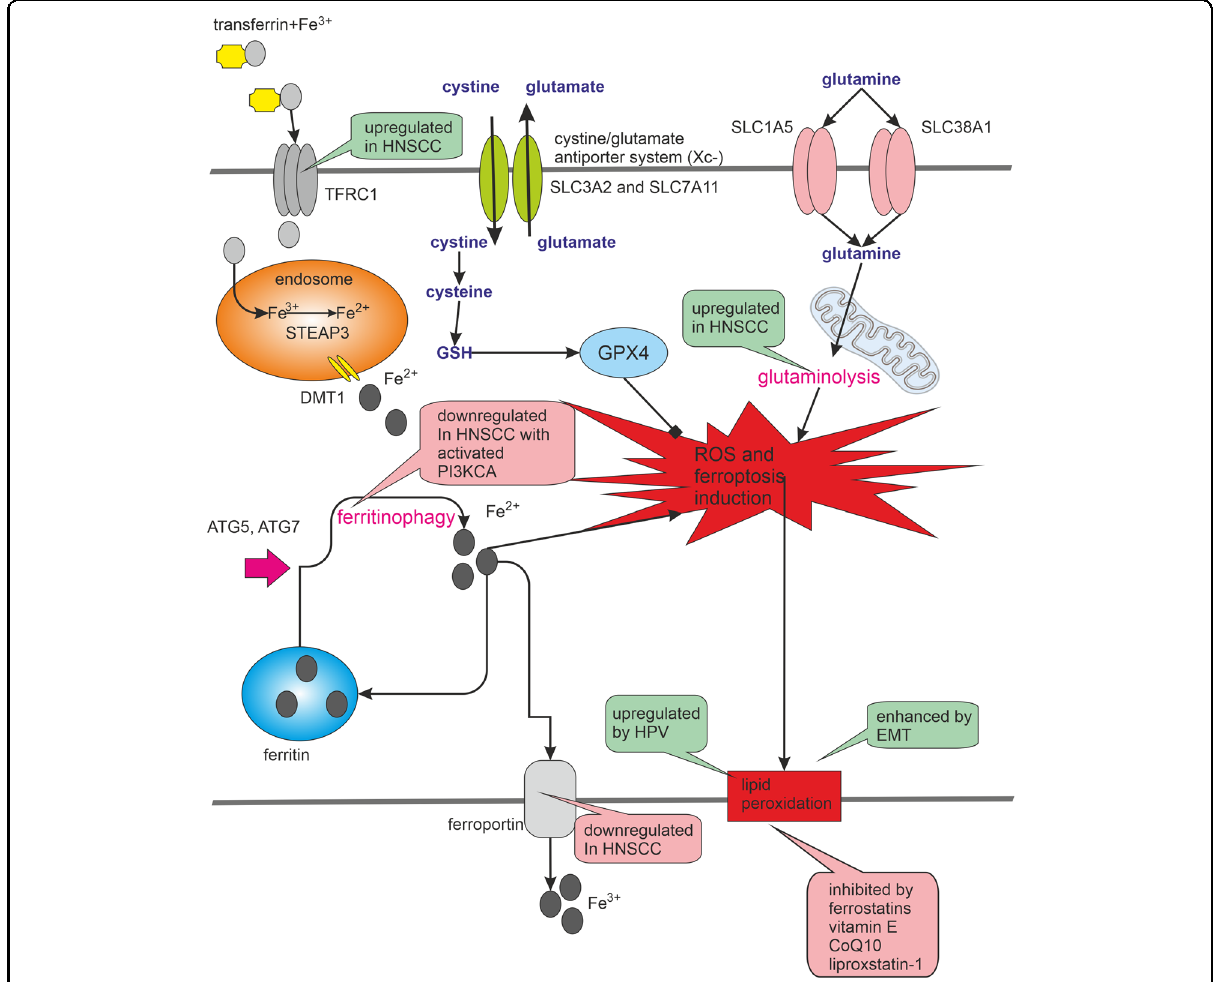
Fig. 3 Ferroptosis. Ferroptosis is characterised by iron-induced lipid peroxidation. The intracellular concentration of iron can be affected by the activity of transferrin, transferrin receptor and ferroportin, or by the release of iron from ferritin, which is often managed by ferritinophagy. HNSCC cells often manifest an increased intracellular iron concentration due to a high level of TFRC1 (transferrin receptor 1 responsible for cellular iron uptake) and a low abundance of ferroportin (responsible for iron ef fl ux). The non-physiological degree of lipid peroxidation and the initiation of ferroptosis is prevented by glutathione and glutathione peroxidase 4 (GPX4) activity. Ferroptosis could be also prevented with chelating agents or vitamin E, which casts a bad light on the bene fi ts of antioxidants in the treatment of some ferroptosis-prone cancers. Glutamine and glutaminolysis also play a crucial role in the activation of ferroptosis. PI3KCA is among the most frequently mutated and activated genes in HNSCC. PIK3CA activation can lead to increased mTOR activity and decreased autophagy. Consequently, the presence of PI3KCA activation may predispose these cancer cells to avoid autophagy, ferritinophagy and ferroptosis. The ferroptotic signalling pathways are signi fi cantly in fl uenced by HPV infection and by the genetic background of HNSCC. Green bubbles indicate activation and pink inhibition of the